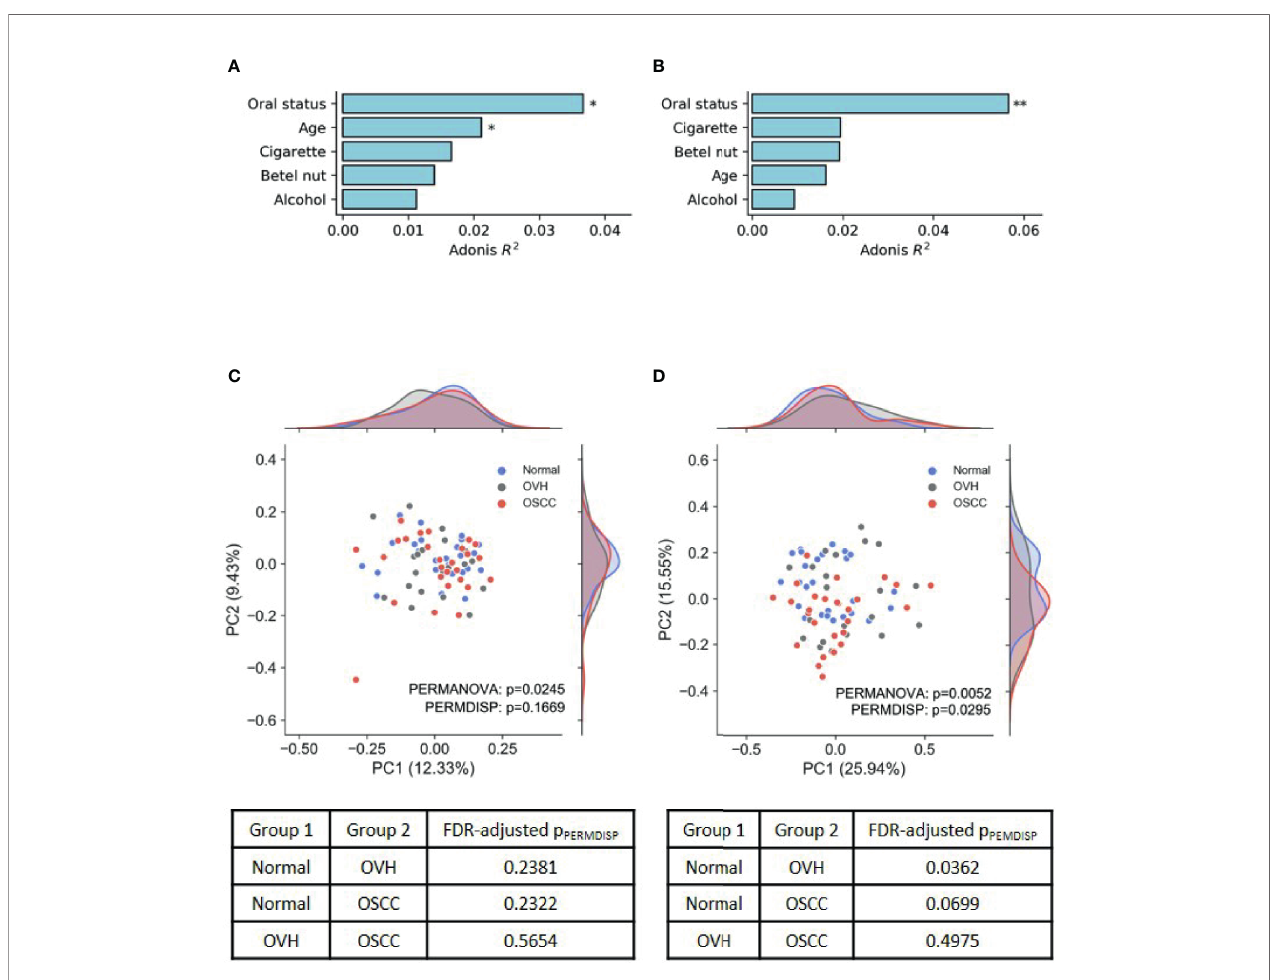
FIGURE 1 | Differences in oral microbiomes among normal, OVH, and OSCC cohorts. (A, B) Adonis analysis based on (A) unweighted and (B) weighted UniFrac distance metrics shows the effect ( R 2 ) of factors with the oral microbiome. * indicates FDR-adjusted p < 0.05 and ** indicates FDR-adjusted p < 0.01. (C, D) Principal coordinate analysis (PCoA) plots of taxonomic pro fi les based on (C) unweighted and (D) weighted UniFrac distance metrics. Marginal kernel densities visualize the distribution of microbial diversity along both axes. The pairwise PERMDISP reveals the dispersion effect (FDR-adjusted p < 0.05) between normal and OVH